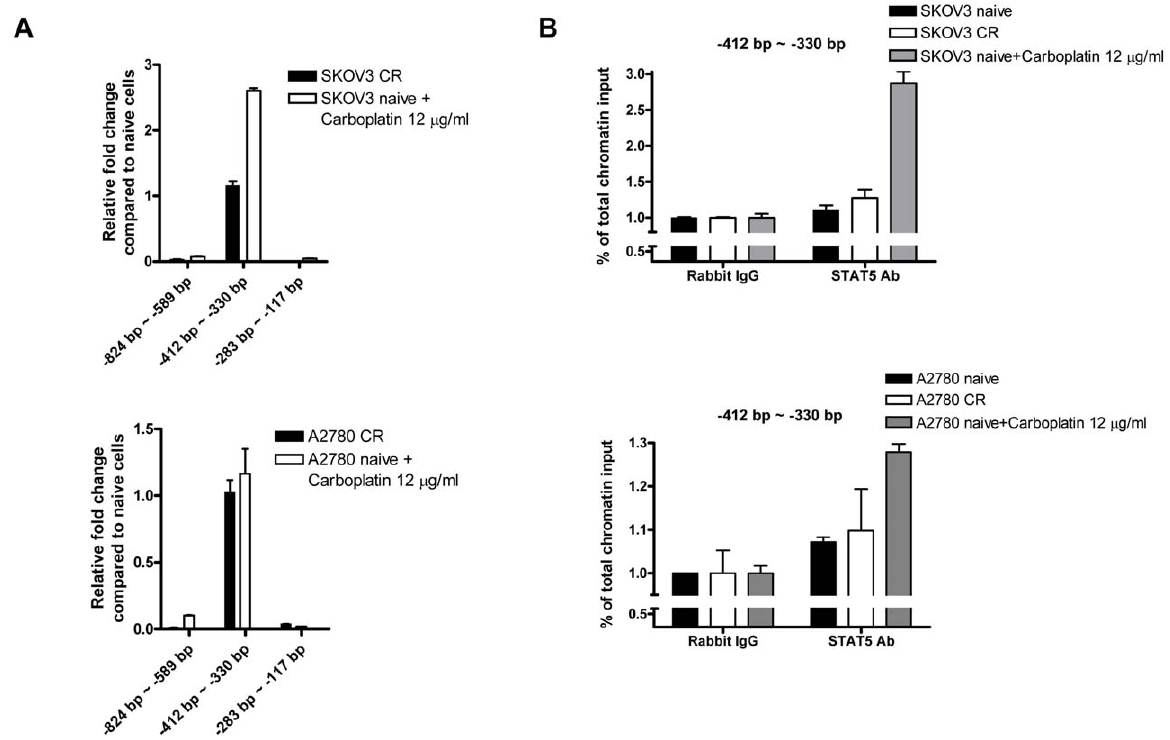
Figure 4. Chromatin immunoprecipitation (ChIP) assay of the Bcl-X promoter using STAT5 antibody in chemoresistant cells, their naı¨ve counterparts, and naı¨ve cells treated with high-dose carboplatin. A) Relative fold enrichment of immunoprecipitated genomic fragments by quantitative PCR in chemoresistant cells and in naı¨ve cells treated with 12 m g/ml carboplatin for 24 hours, as compared to the untreated naive counterparts. Fragment ‘‘ 2 412 bp , 2 330 bp’’ contains both RELA and STAT5 binding sites, while fragment ‘‘ 2 824 bp , 2 588 bp’’ on the 5 9 side of RELA and STAT5 binding sites and fragment ‘‘ 2 283 bp , 2 117 bp’’ on the 3 9 side serve as negative controls. Top panel: SKOV3; bottom panel: A2780. B) STAT5-bound chromatin in relation to % of total chromatin input of the ‘‘ 2 412 bp , 2 330 bp’’ region. Rabbit IgG-bound chromatin serves as control. Top panel: SKOV3; bottom panel: A2780.